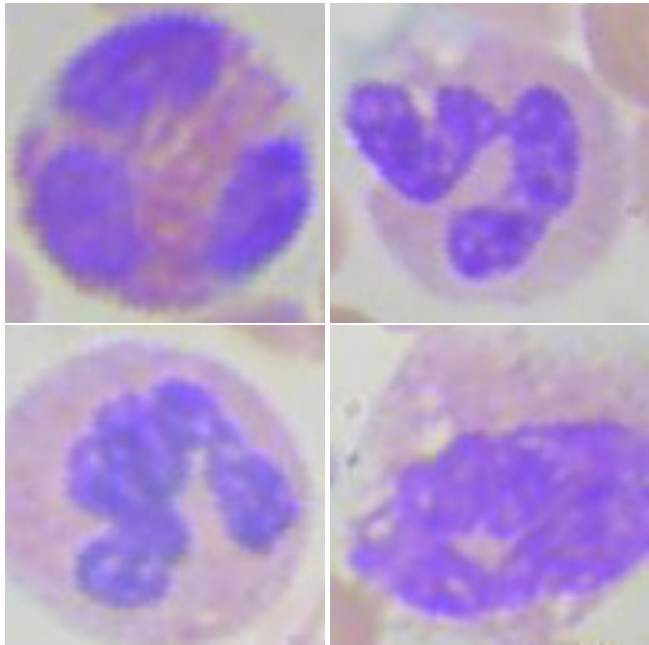
Figure 5. Polymorphonuclear cells classified by the proposed multi-level convolutional neural network. ( upper-left ) Eosinophils correctly classified; ( upper-right ) neutrophils correctly classified; ( lower-left ) eosinophils incorrectly classified as neutrophils; ( lower-right ) neutrophils incorrectly classified as